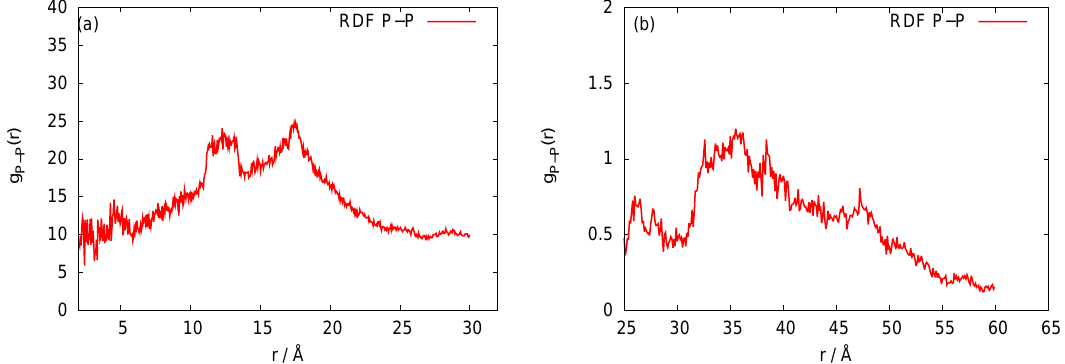
Figure 2. Behaviors of the P-P radial distribution functions for the five rings RNA nanotube with ( a ) all-atom Molecular Dynamics (MD) simulation and ( b ) coarse-grained